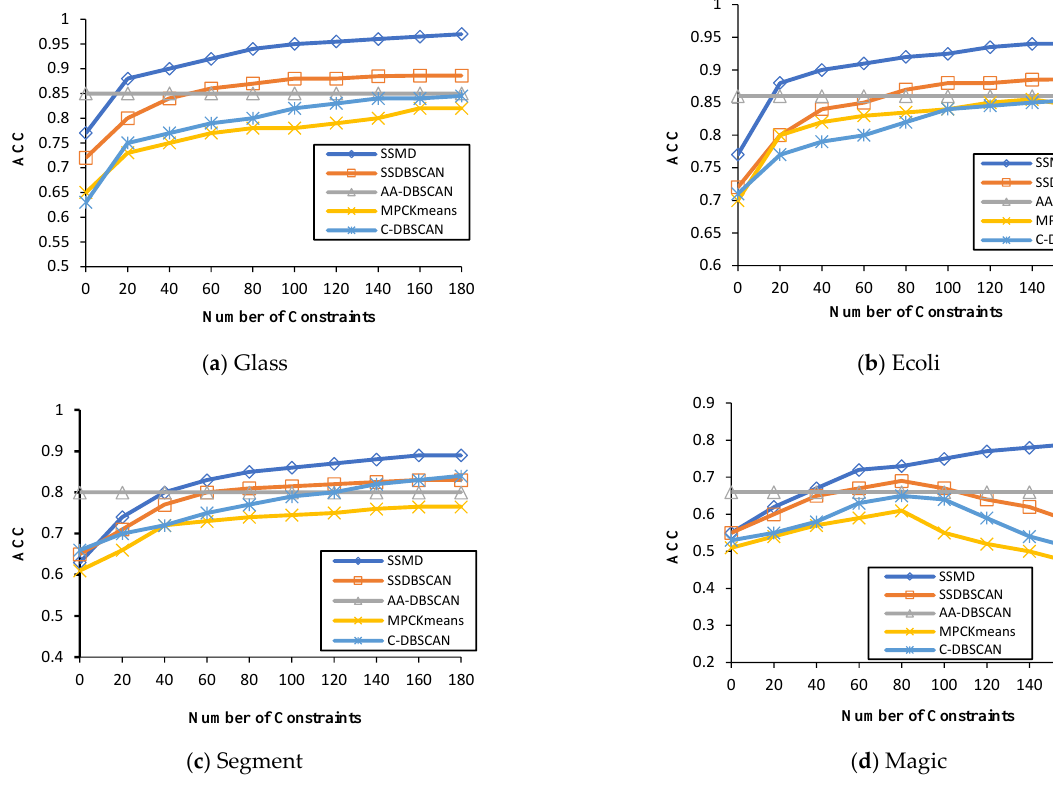
Figure 2. Comparison of clustering accuracy.